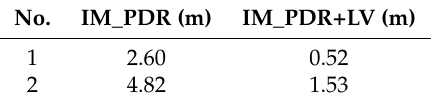
Table 6. Maximal positioning errors of improved PDR and LV algorithm based on the improved